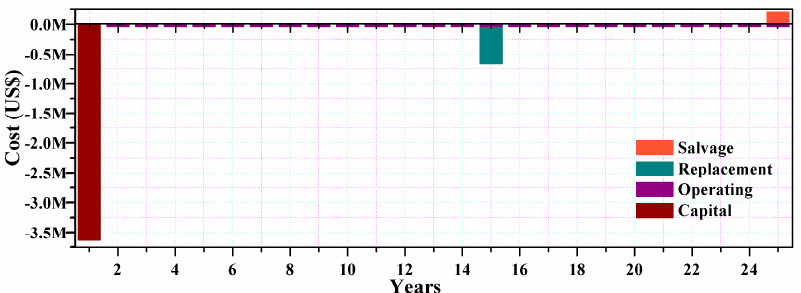
Figure 15. Yearly cash flow diagram of scenario 5 by cost type.